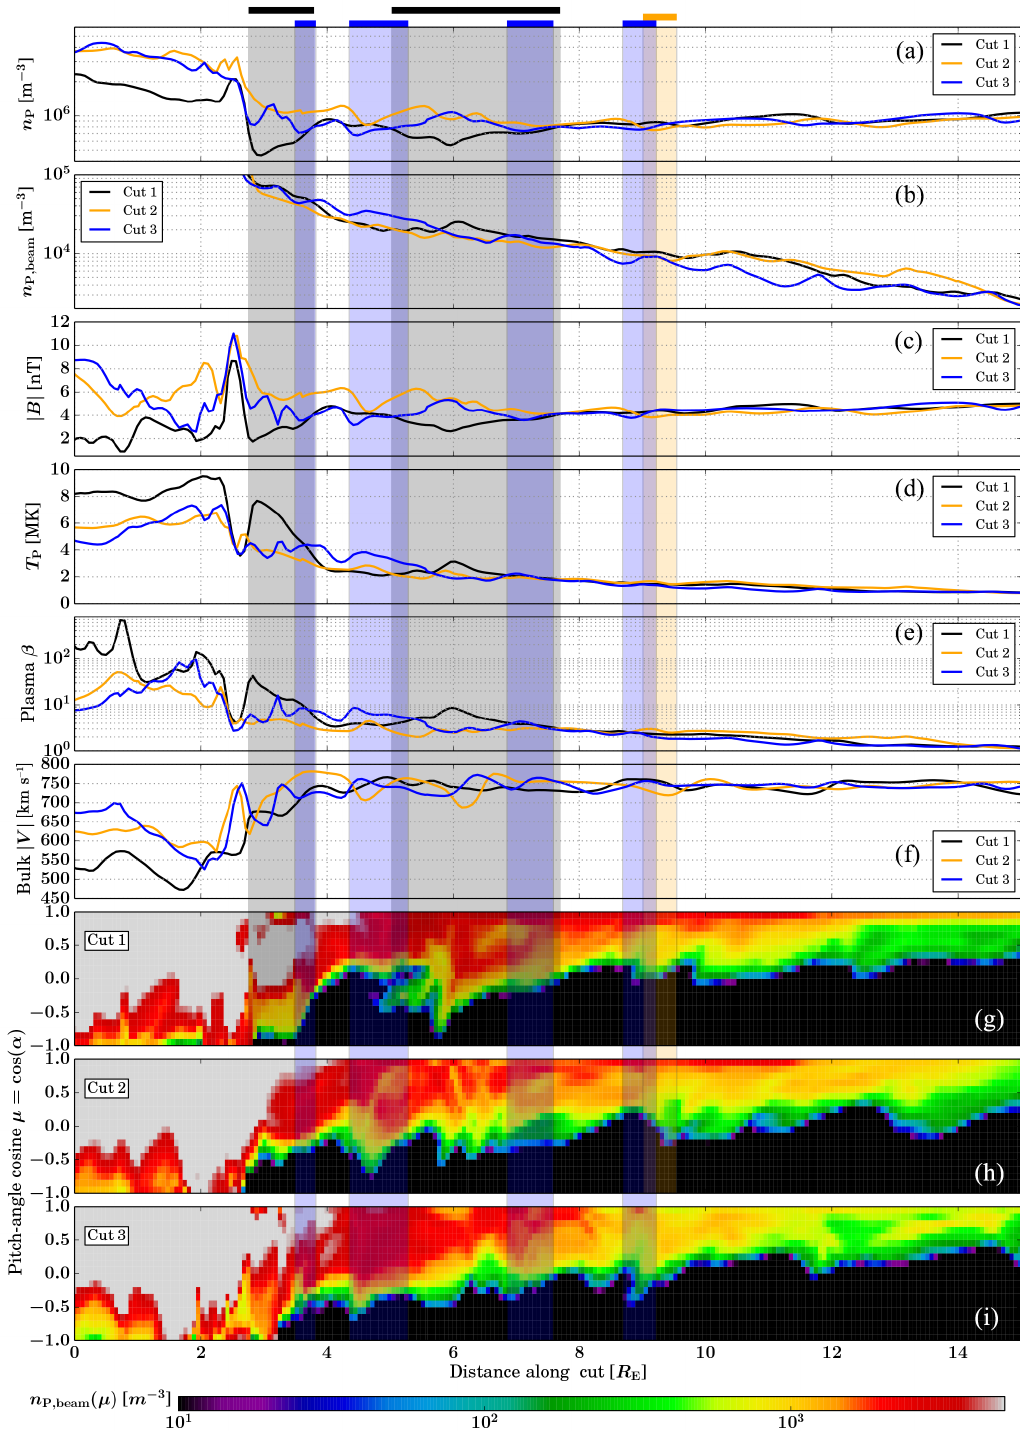
Figure 7. Profile cuts from the magnetosheath across the shock into the foreshock region at three different positions (as shown in Fig. 5), at time T R = 1187 . 85s. Rectangular areas shaded in grey, yellow, and blue indicate the regions at each of the cuts (1, 2, and 3, respectively), which fulfill our caviton criteria of n P < 0 . 8 n P, sw and | B | < 0 . 8 | B SW | . Each shaded area is accompanied by a indicator bar above panel (a) . Panels (g) , (h) and (i) display heat maps of pitch-angle cosine cos (α) for the suprathermal beam distribution of protons, measured in the plasma reference frame, with respect to the local magnetic